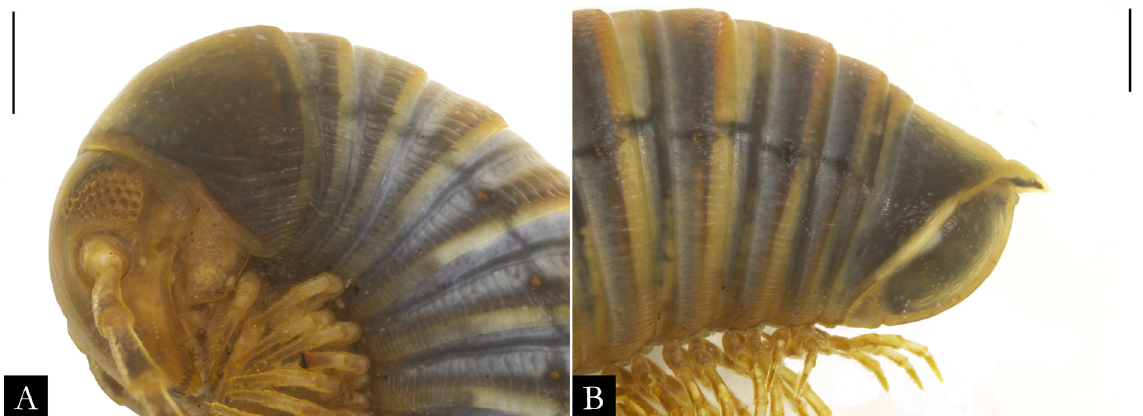
Fig. 53. Pseudonannolene buhrnheimi Schubart, 1960, ♀ (IBSP 2397), in lateral view. A . Anterior region. B . Posterior region. Scale bars = 1 mm.